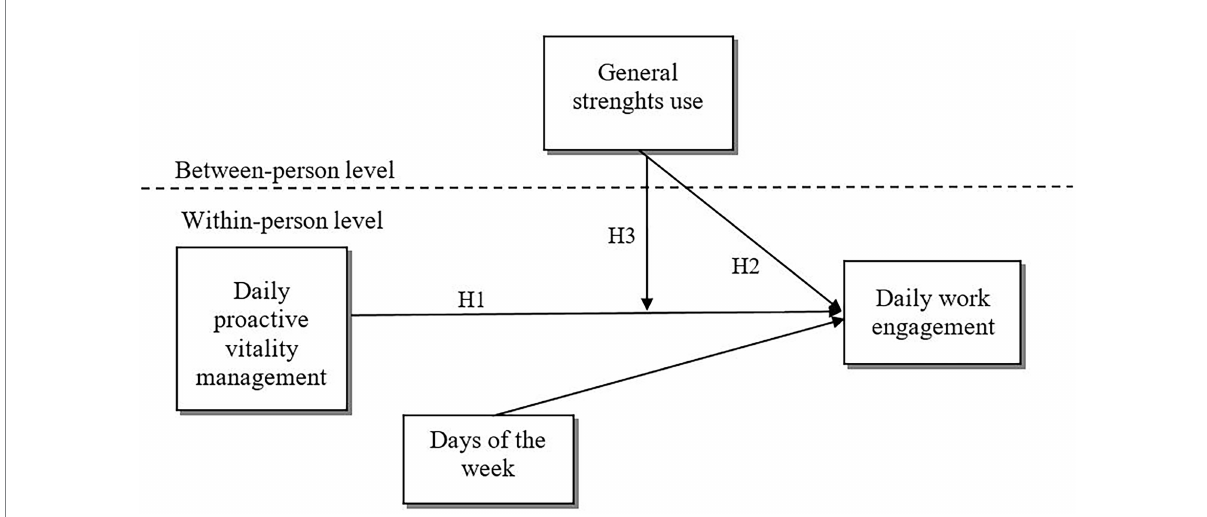
FIGURE 1 A multi-level model of work engagement, proactive vitality management, and strenghts